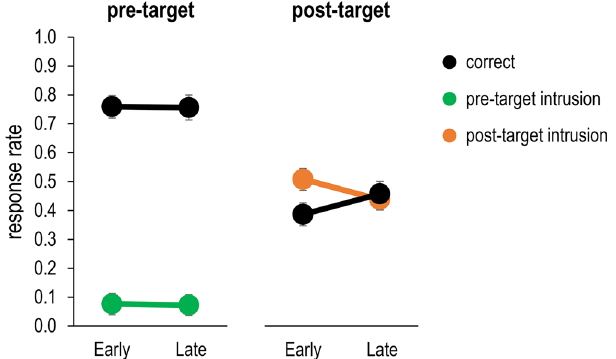
Figure 7. Frequency of correct responses (black lines), pre-target intrusions (green lines) and post-target intrusions (orange lines) in Experiment 1, as a function of the distractor condition (pre-target digit vs. post- target digit) and the target’s temporal position in the RSVP stream (early vs. late, i.e., 5th and 6th positions vs. 7th and 8th positions). Error bars denote one standard